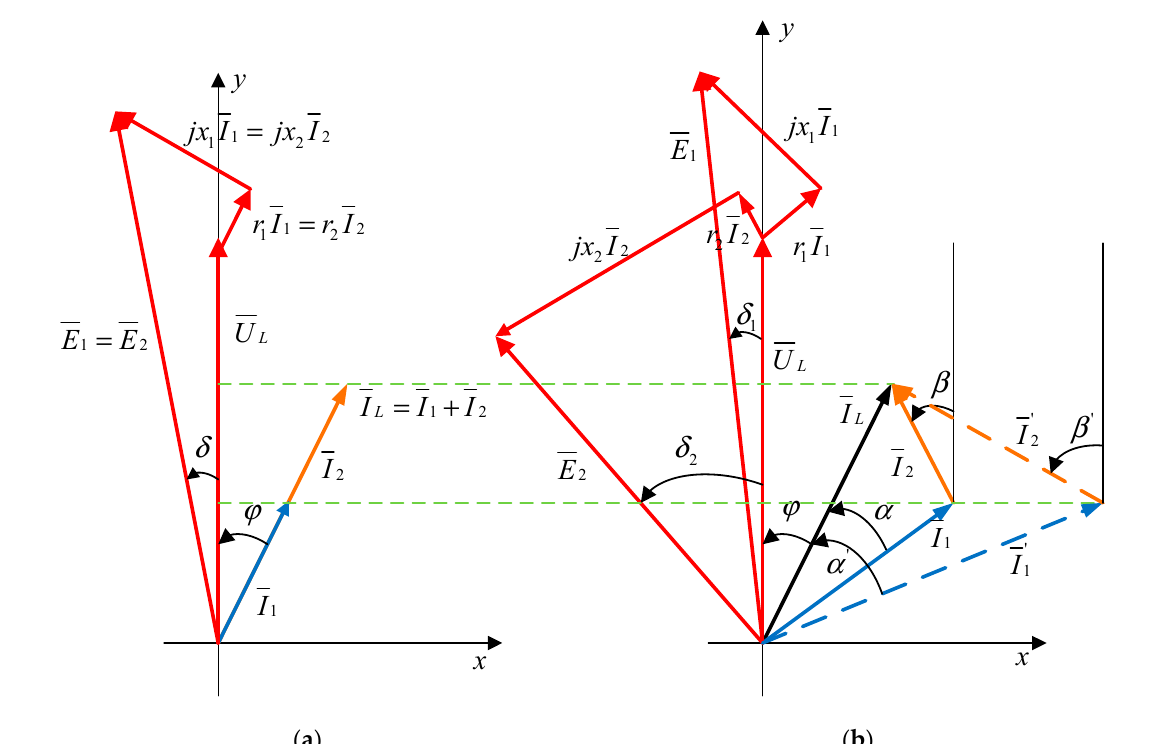
Figure 3. Vector diagrams of generators operating in parallel: ( a ) in the symmetrical operation mode; ( b ) in the asymmetrical operation mode.